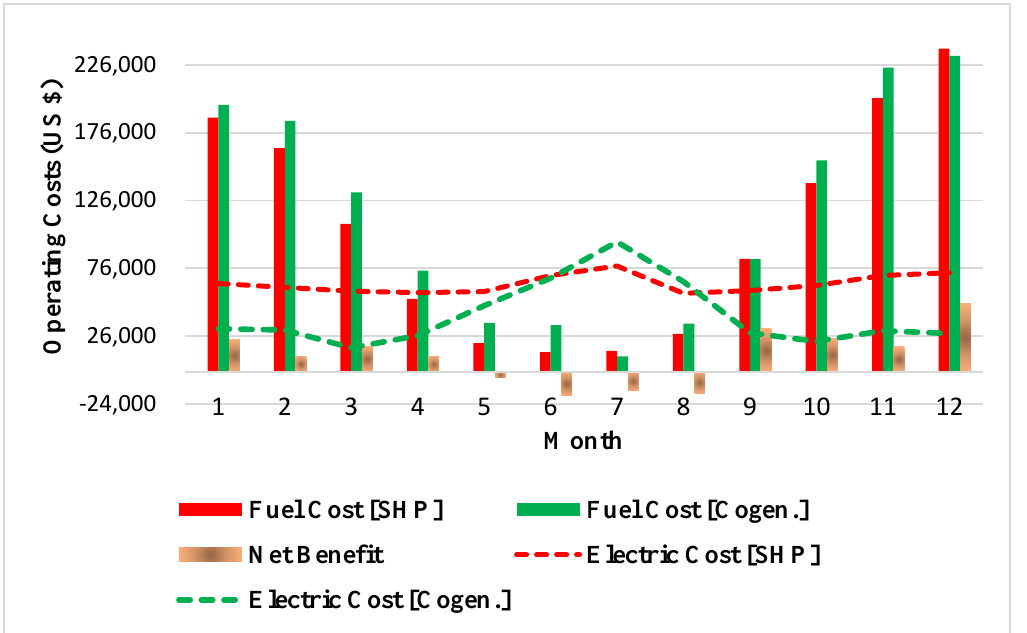
Figure 12. Comparison of the operational costs and net benefit by month before and after the installation of the cogeneration system.